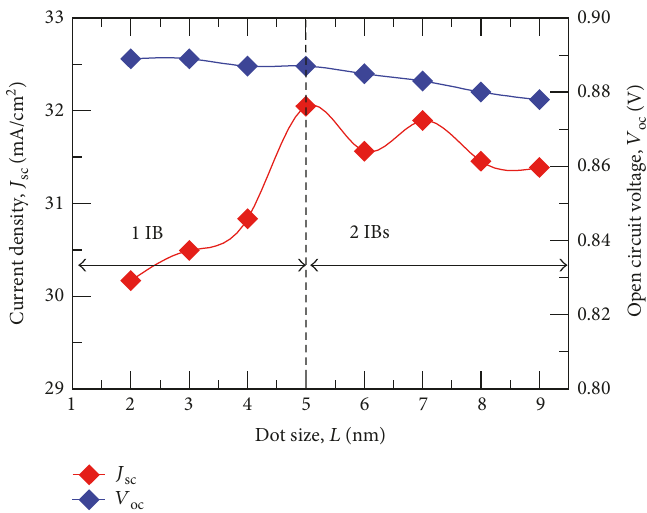
Figure 8: Dot size versus J